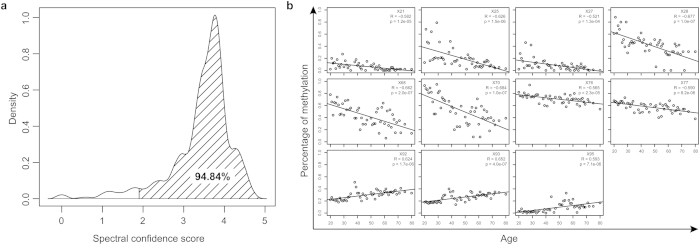
Validation of age-associated methylation sites by using Sequenom MassARRAY in 50 healthy females.(a) The reliability of the Sequenom MassARRAY output data. The confidence of methylation values for each product of primer per sample was assigned to a value referring to low (0) to high confidence (5). This value > 1.9 showed that the methylation level can be accepted. Our data from Sequenom MassARRAY is of high quality since 95% values were accepted. (b) Scatter plots of the methylation level as a function of age for 11 CpG sites that were selected from the Sequenom MassARRAY result at |R| < 0.5. The ID of CpG sites and their R values are shown in the right top corner of each sub-figure.